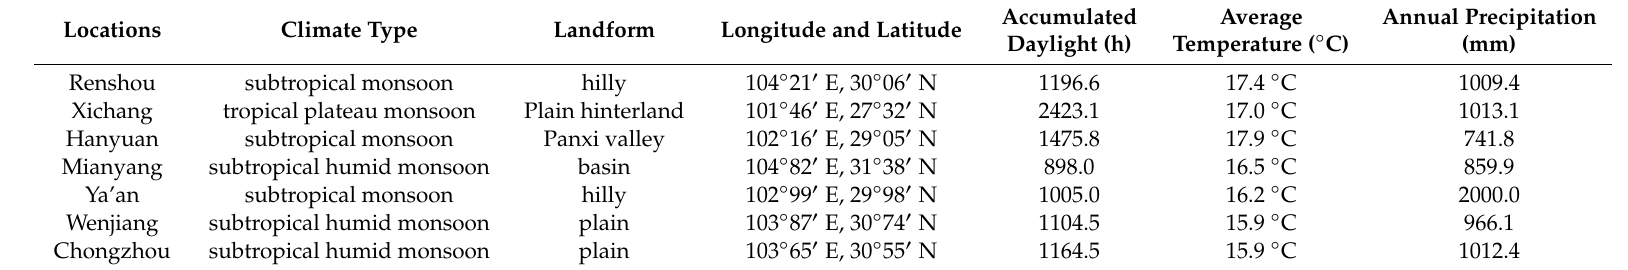
Table 2. Climate, Geography, and environment of the field